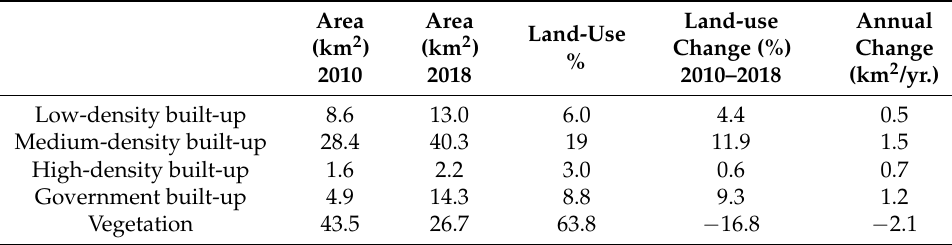
Figure 4. Relationship between socio-economic variables and government built-up areas in Uyo from 2010 to 2018. Table 3. Correlation coefficients between socio-economic variables and built-up areas. Direct Tax Indirect Tax Investment Tax Federal Allocation 0.03 ** 0.62 ** ** p > 0.004, ** m > 1. Table 4. Land-use change statistics in Uyo from 2010 to 2018.